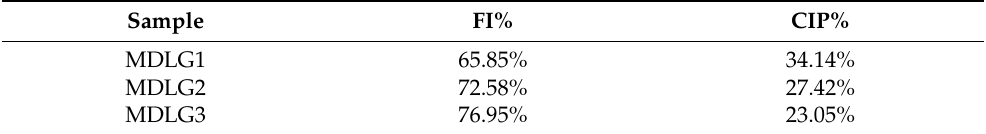
Table 1. The percentages of ions.